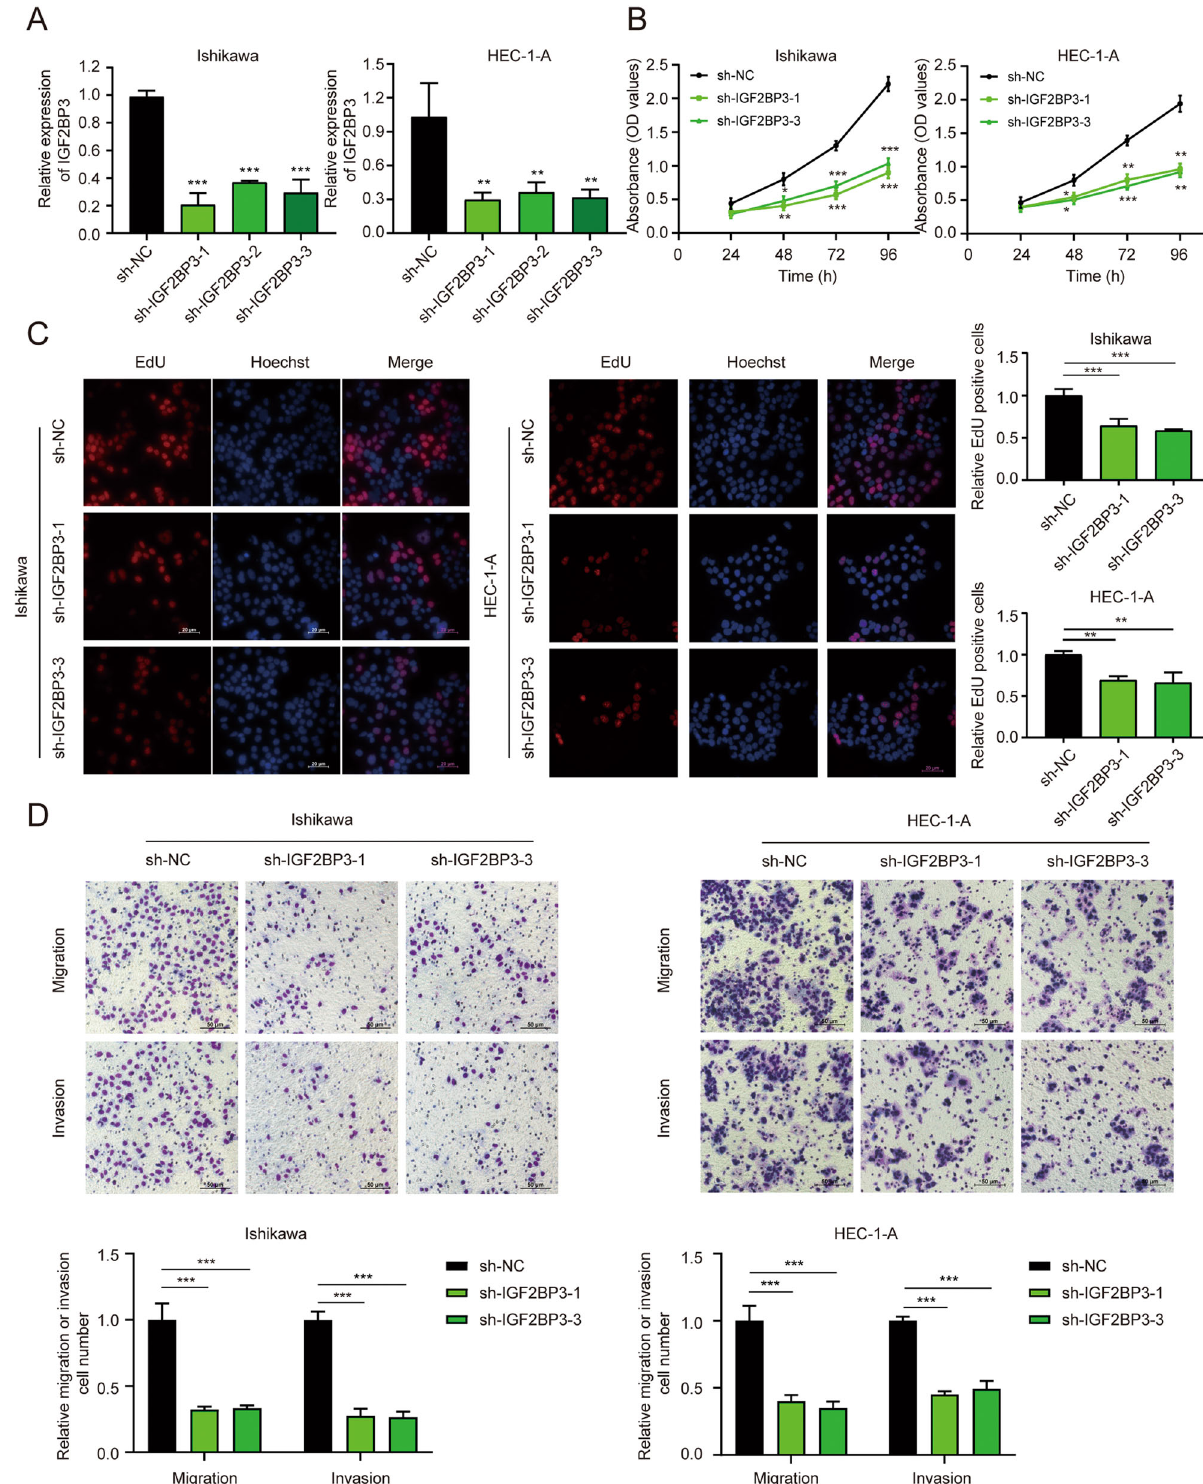
Fig. 2 Knockdown of IGF2BP3 inhibited EC cell progression in vitro. A The mRNA expression level of IGF2BP3 was knocked down by three shRNAs in Ishikawa and HEC-1-A cells. B and C CCK-8 assays ( B ) and EdU assays ( C ) were employed to evaluate the cell proliferation ability in IGF2BP3-silenced EC cells. D Transwell assays were conducted to assess the migration and invasion of IGF2BP3-silenced EC cells. The quanti fi cation results are on the near side of their representative images. * P < 0.05, ** P < 0.01, *** P < 0.001. Data, mean ± S.D. All experiments were independently repeated with at least three